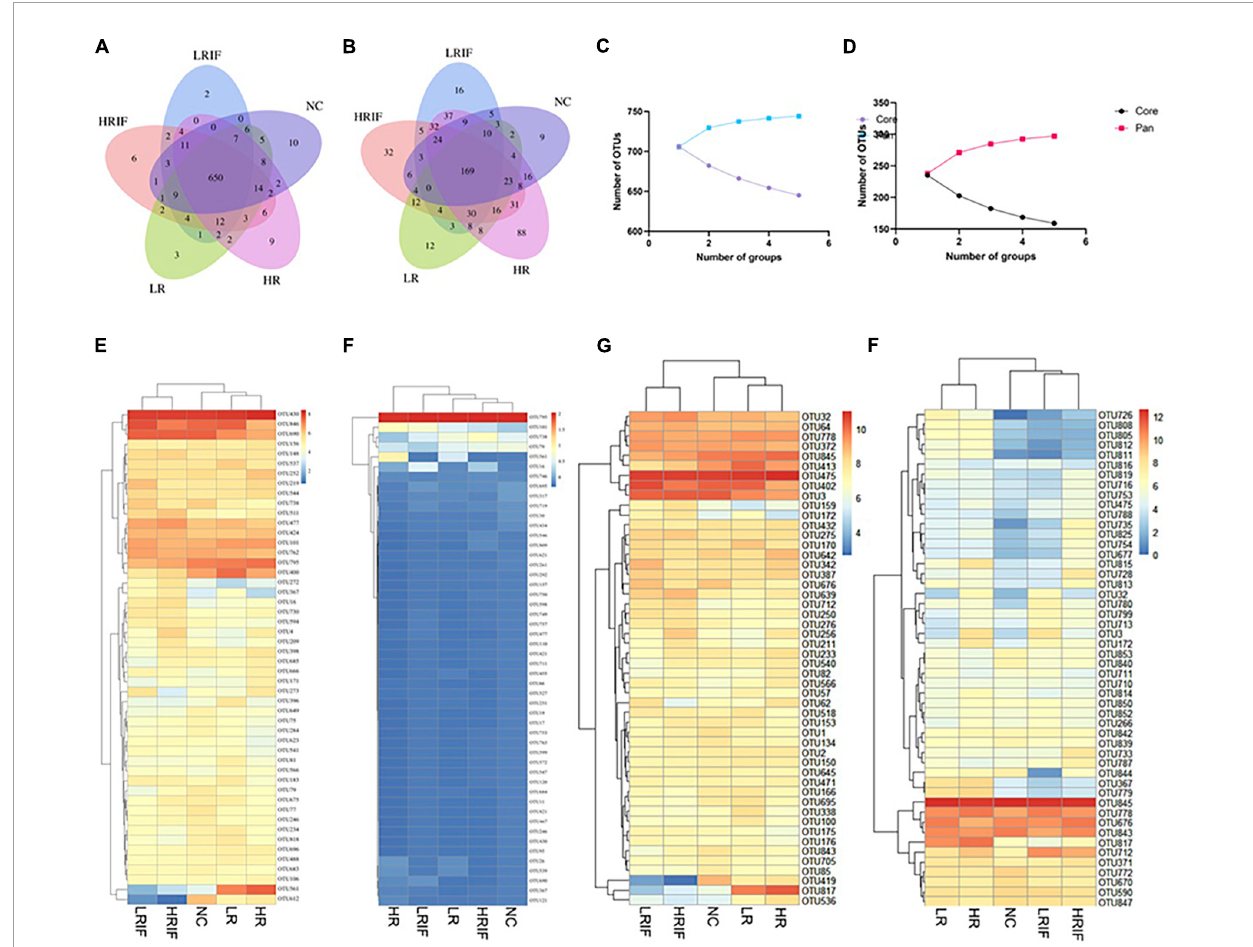
FIGURE5 Relative abundance analyses at the OTU level of the microbial communities of the feces and ileum. (A) Venn diagram of shared and unique genera among five groups in fecal samples. (B) Venn diagram of shared and unique genera among five groups in ileal samples. (C) Pan and core OTUs of fecal samples. (D) Pan and core OTUs of ileal samples. (E) Heatmap showing the top 50 OTUs with most significant difference among five groups in fecal samples. (F) Heatmap showing the top 50 OTUs with most significant difference among five groups in ileal samples. (G) Heatmap showing the most abundant top 50 OTUs in fecal samples. (H) Heatmap showing the most abundant top 50 OTUs in ileal